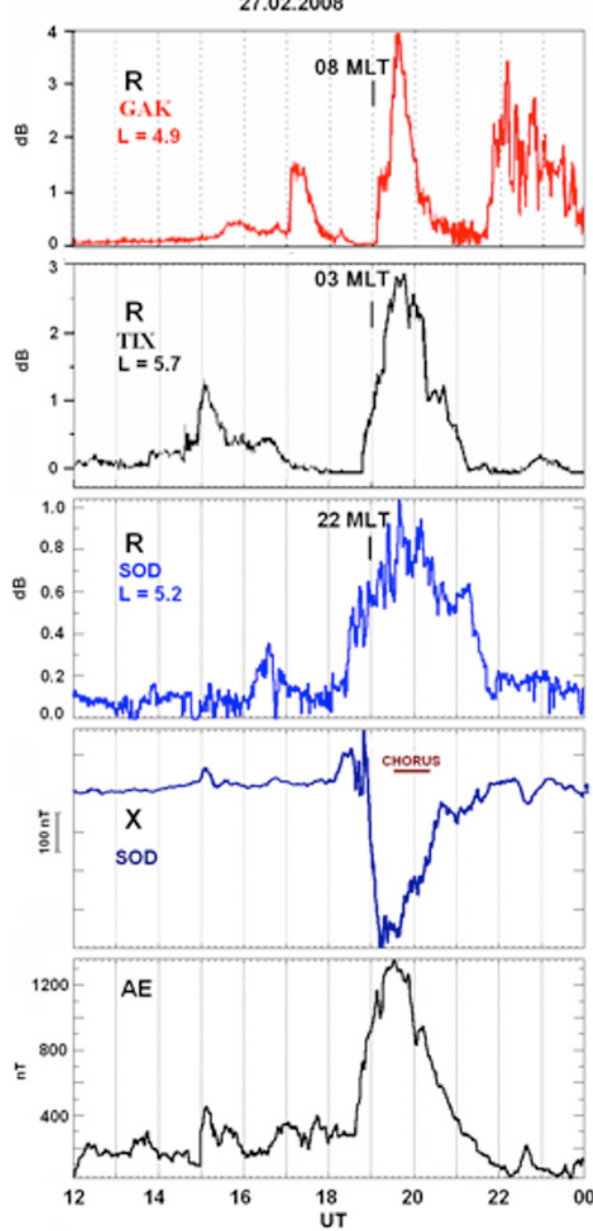
Fig. 2. Riometer data at three stations (GAK, TIX and SOD), X- component at SOD, and the variations of